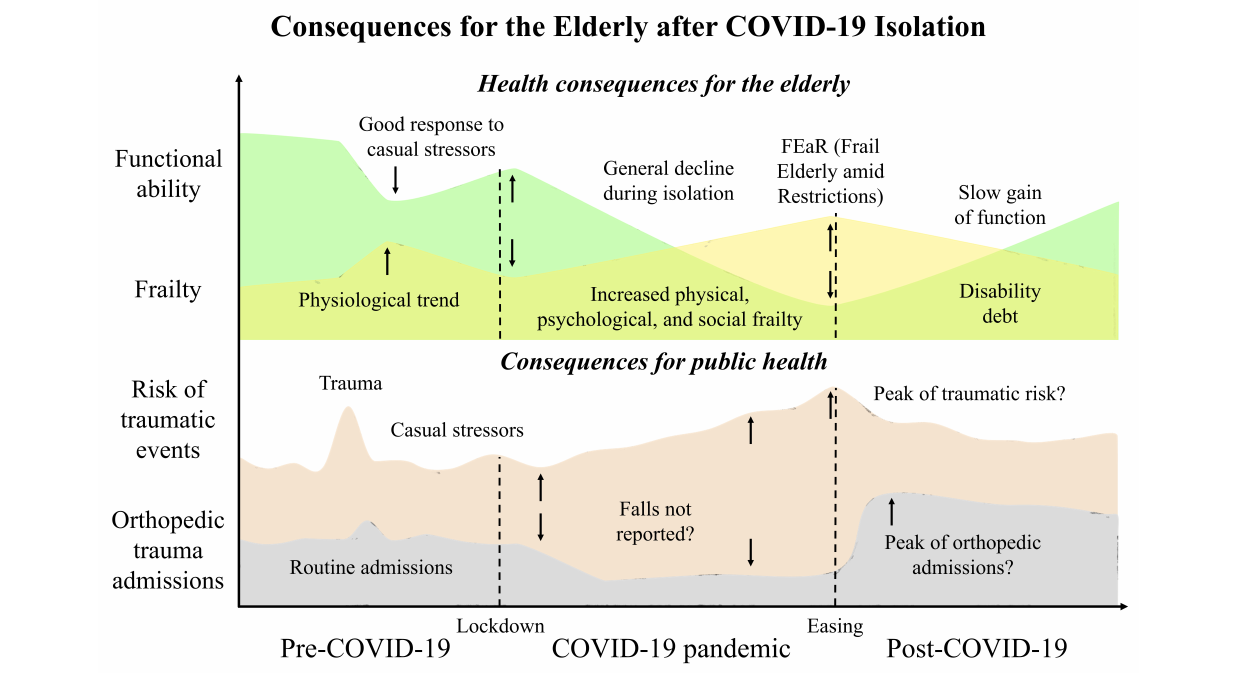
FIGURE 1 | Tendencies of the consequences of the COVID-19 pandemic on the health of the elderly and the risk of hospital admissions after lockdown easing. The severe acute respiratory syndrome coronavirus that was discovered in Hubei province, China at the end of December 2019 (SARS-CoV-2) burst a pandemic that shut down the world. Under normal circumstances, the older adults must deal with a diminished functional ability and progressive establishment of geriatric fragility. If a healthy status is present, recovery from any trauma is discreet even if it is not associated with full pre-trauma functionality. Although restrictive measures were necessary for public health during the pandemic, they have exposed older individuals to confinement that has worsened their physical and mental health. Upon easing of the lockdown, the older person will suffer a disability debt, which will make him highly vulnerable to the risk of falling. Orthopedic hospitals that recorded a halving of traumatic admissions could contrariwise encounter a surge in accesses for traumas amid lockdown